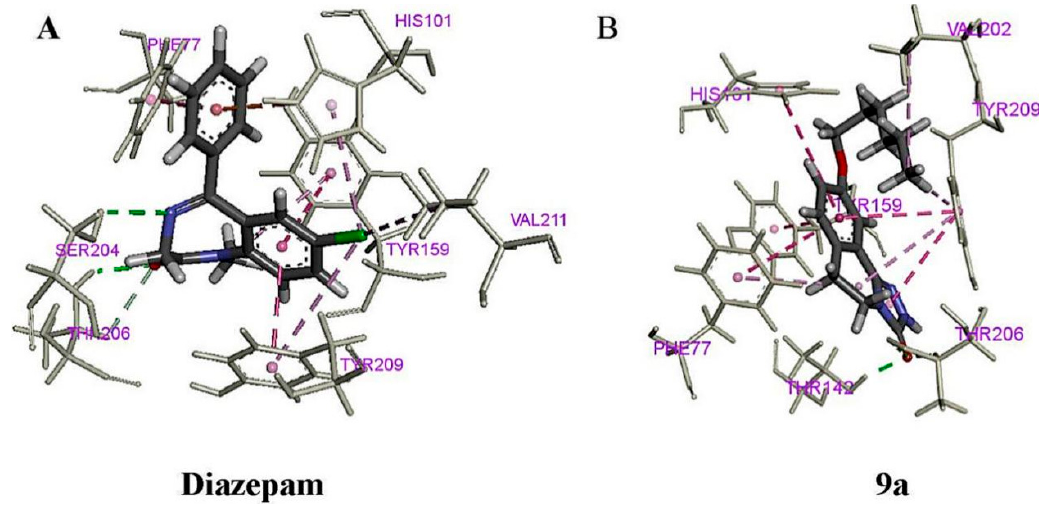
Figure 3. Images of docked complexes of GABA A with diazepam and compound 9a (thick color sticks) making interactions (color dotted lines) with residues at the BZD-binding site (silver-white sticks). ( A )